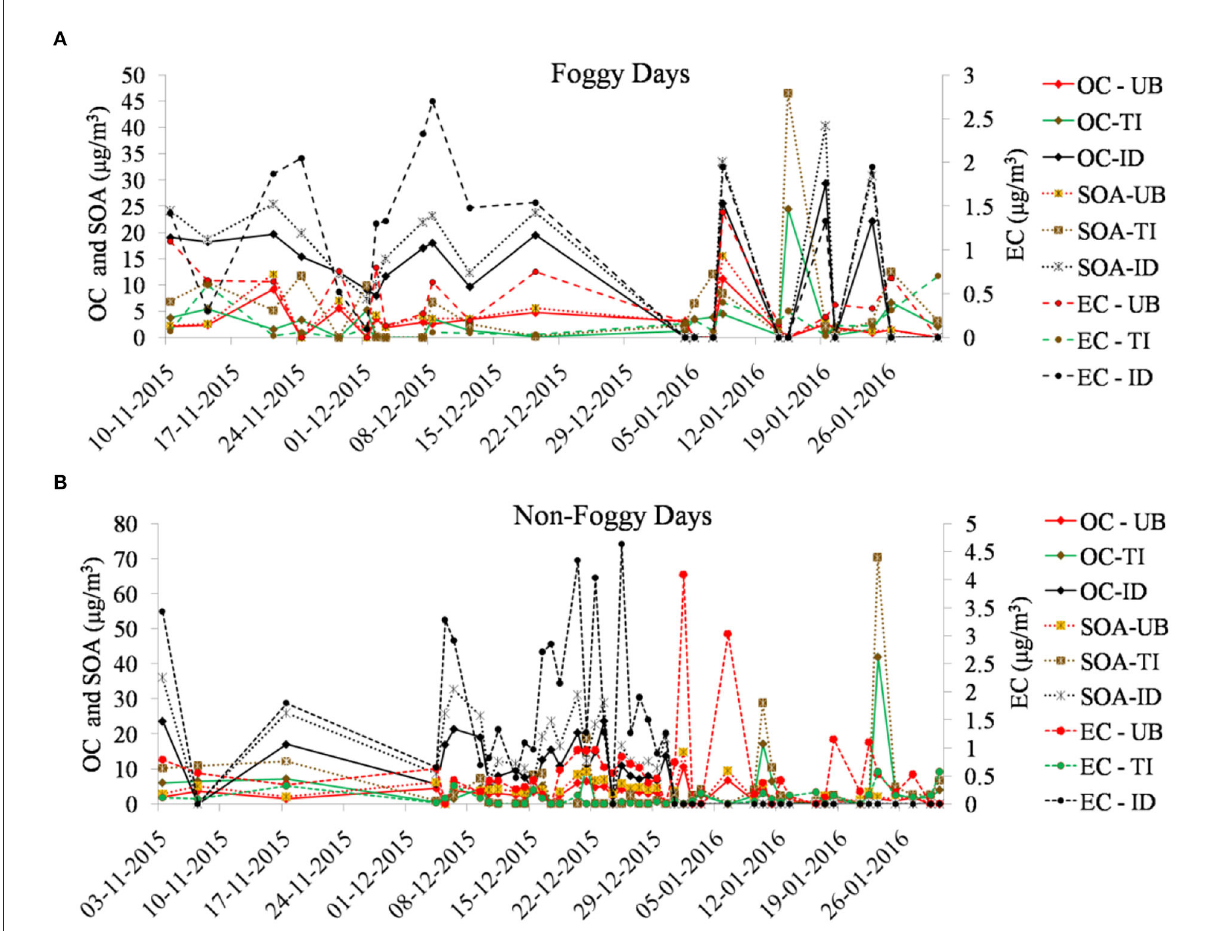
FIGURE2 Time series of the carbonaceous components during (A) foggy days and (B) non-foggy days.